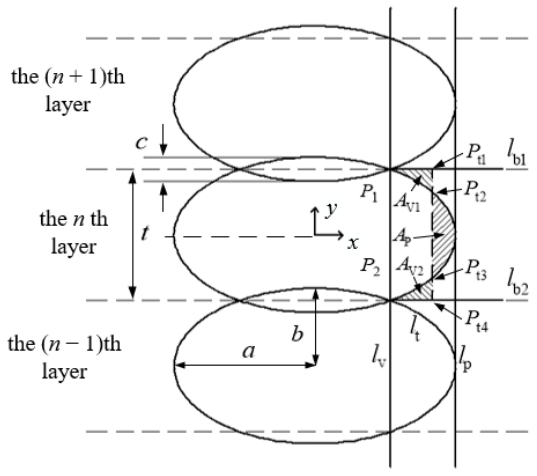
Figure 3. SRVF-HB model schematic.